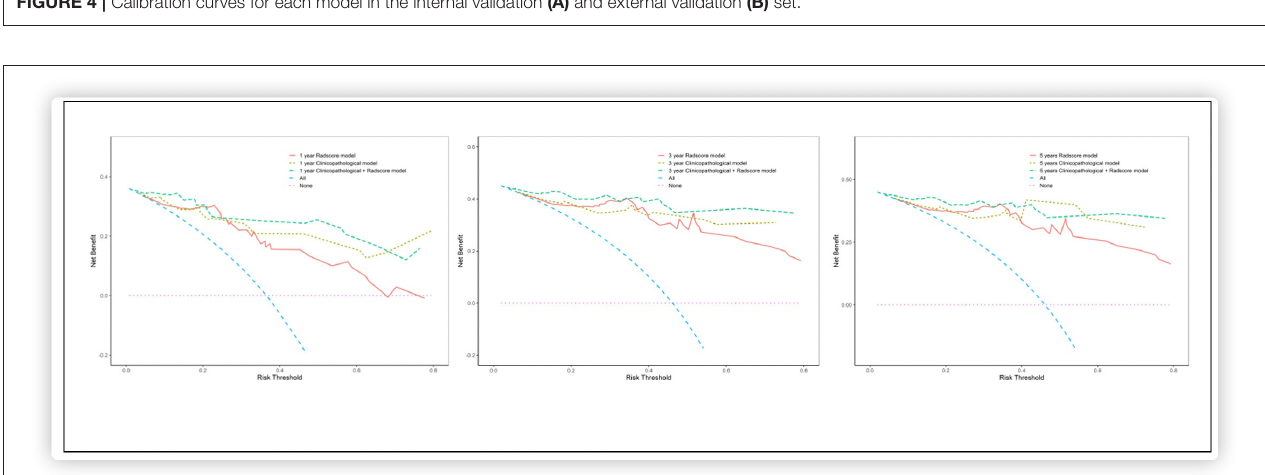
FIGURE 4 | Calibration curves for each model in the internal validation (A) and external validation (B) set.